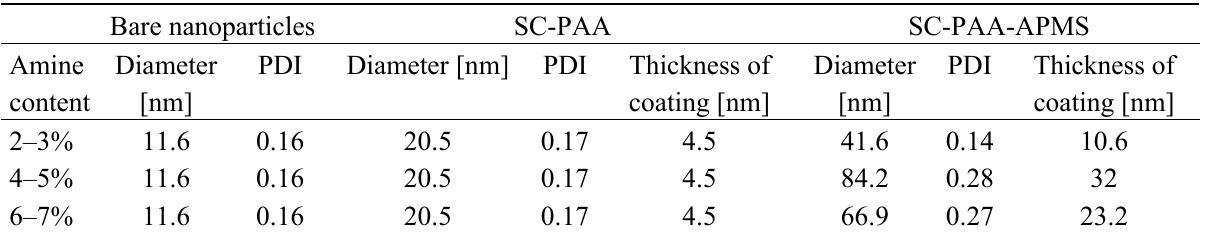
Table 1. Hydrodynamic diameters of bare, PAA and PAA/PDMS- co -APMS coated nanoparticles. Bare nanoparticles SC-PAA SC-PAA-APMS Amine Diameter Thickness content